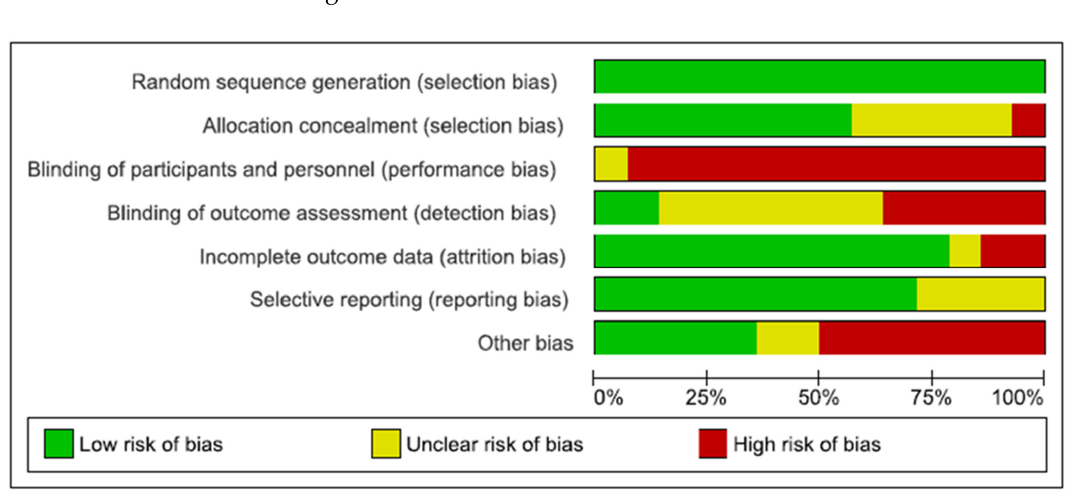
Figure 2. Risk of bias graph: review authors’ judgements about each risk of bias item presented as percentages across all included studies.